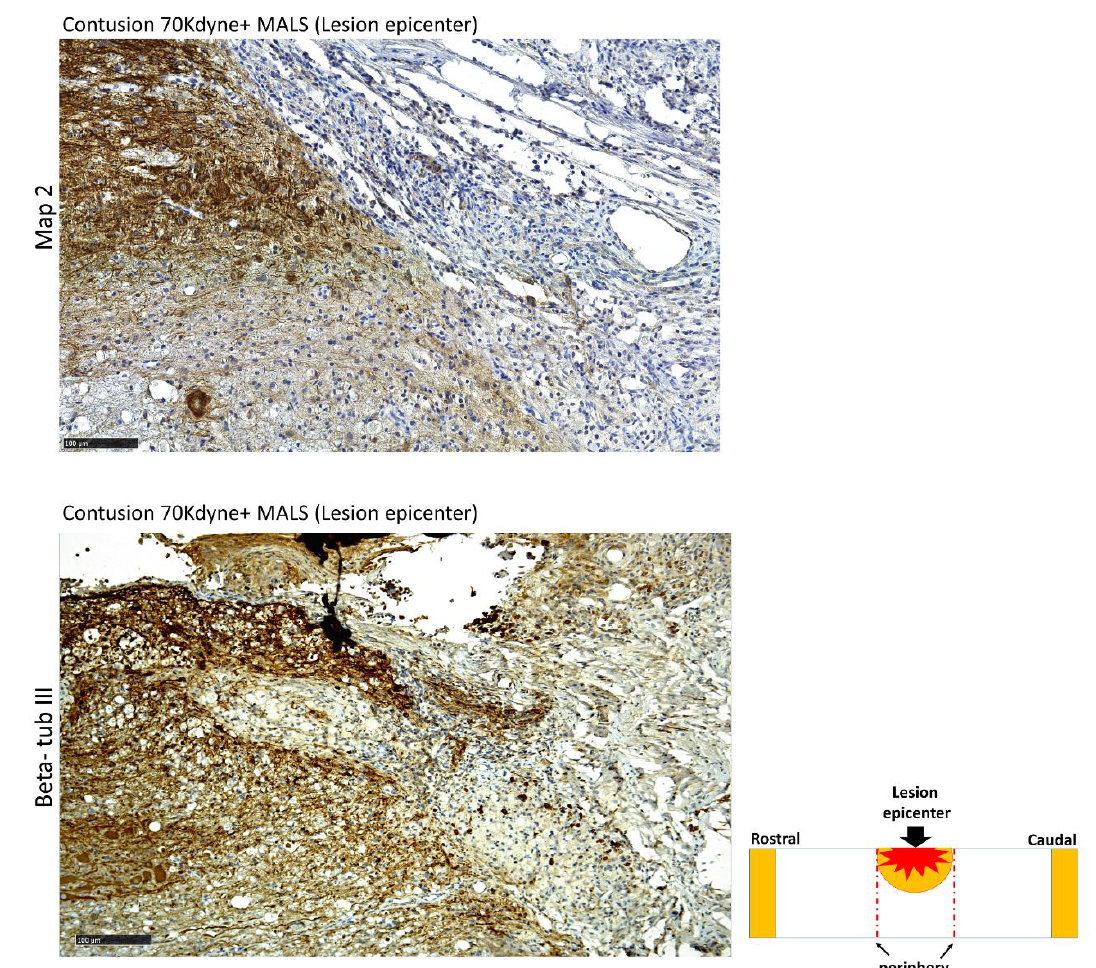
Figure 11. Synergistic interaction between MALS tissue and surrounding spinal cord microenvironment. The contact area between the lesion site and the MALS tissue shows positivity for two neuronal markers: Map2 and beta-tubulin III. Scale bar 100 µm. (n = 4 mice; 2 sections/mouse; 3 fields/section).